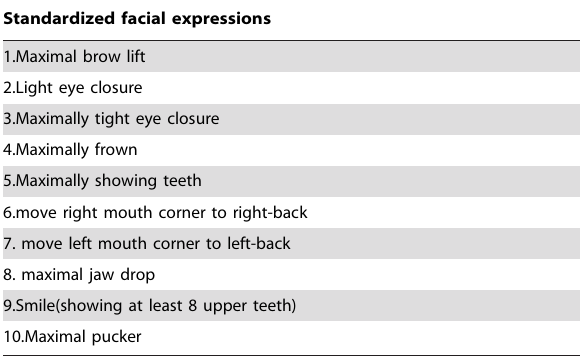
Table 1. Standardized facial